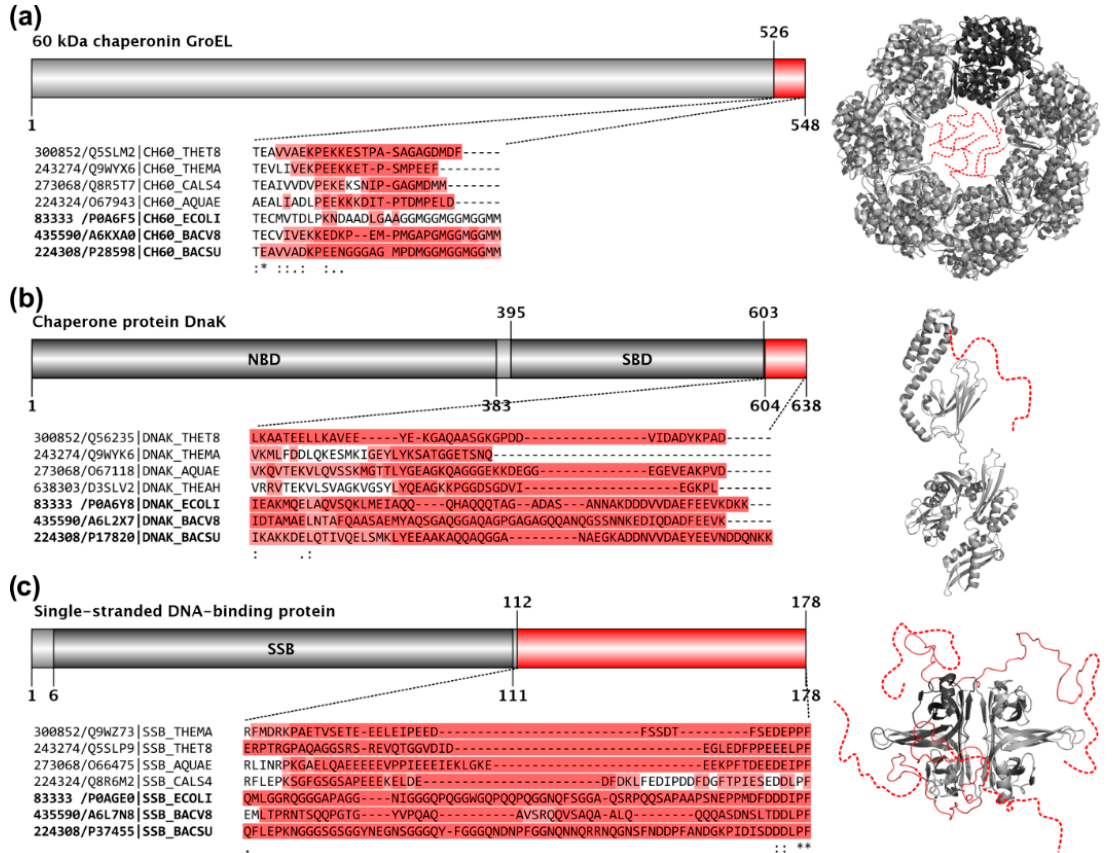
Figure 3. In hyperthermophiles, even essential IDRs are largely shortened. Domain maps, structures, aligned sequences, and IUPred-predicted disordered segments are depicted for three essential proteins, GroEL ( a ), DnaK ( b ), and SSB ( c ), with conserved disordered C -terminal regions that likely exist and function as disordered ensembles in all species [32]. On the grey domain maps, the residue boundaries of conserved disordered segments (in red) and known domains (in darker grey) are provided for the E. coli K12 protein. The red regions of the domain maps complemented by a few residue positions are highlighted as Clustal Omega 1.2.2. multiple sequence alignments below the domain maps. The sequences of the organisms are identified by their Taxonomy/UniProt identifiers. In each case there are four hyperthermophilic sequences shown on the top and three mesophilic reference sequences bellow (identifiers in bold) as a reference. In the alignments the background of the residues are colored according to the corresponding IUPred predictions; residues with a score >0.5 have darker red background, residues with a score between 0.5 and 0.4 have lighter red background, while residues with a score <0.4 have no background. The E. coli structures of the corresponding proteins, GroEL (Protein Data Bank(PDB) ID:2NWC), DnaK (PDB ID:2KHO), and SSB (PDB ID:1QVC), are also depicted in light grey with the conserved disordered segments marked by red or added as red dashed lines (or as the combination of the two). For a better understanding of the correspondences, in both the heptameric GroEL and tetrameric SSB structures, one chain is depicted by darker grey than the others.